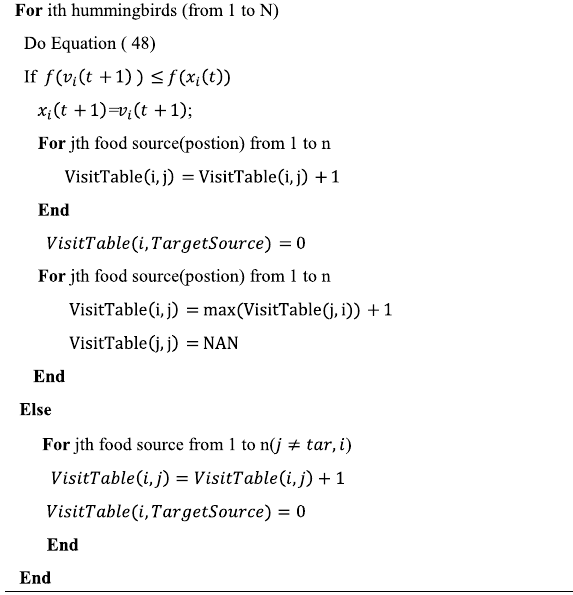
Algorithm 1. Guiding foraging for AHA.